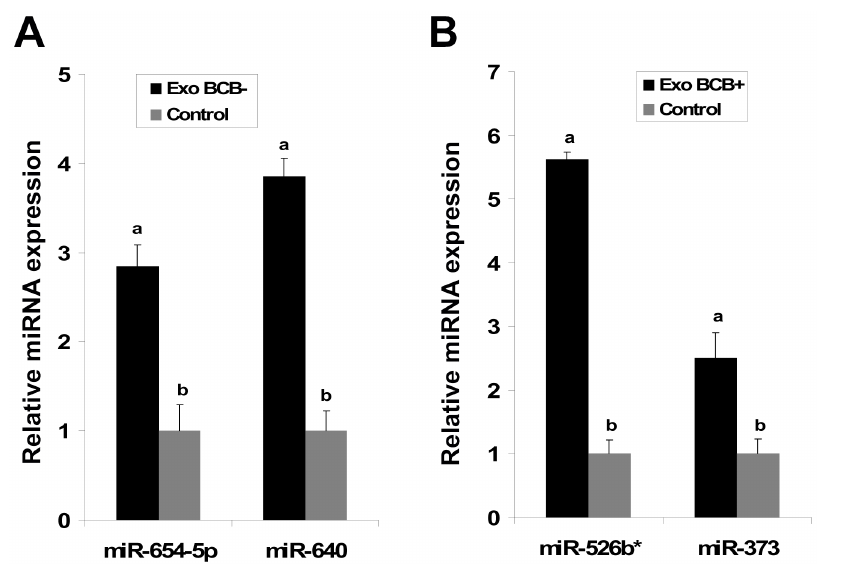
Figure 8. Exosome mediated delivery of miRNAs in bovine granulosa cells invitro . Purified exosomes from follicular fluid of follicles from growing (Exo BCB-) or fully grown (Exo BCB + ) oocytes were co-cultured with bovine granulosa cell. After 24 hrs of incubation at 37 u C in a humidified incubator, cells were collected and subjected to total RNA extraction. The expression levels of candidate miRNAs were investigated by real time PCR. In both cases the level of endogenous miRNAs were significantly increase compared to untreated controls. Bars with different superscript letters (a,b) are significantly different (P , 0.05) from each other. The data is presented as means 6 SD of three biological replicates.